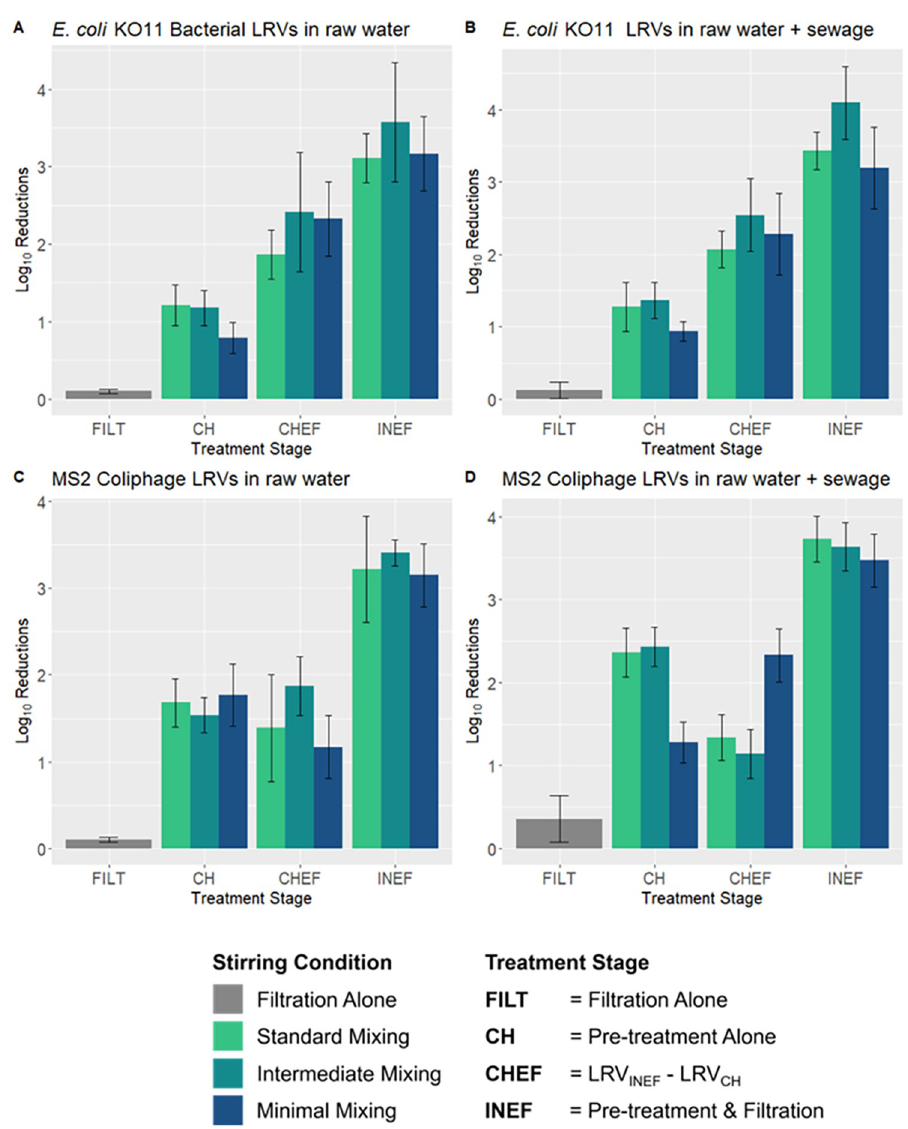
Fig 1. Mean LRVs and their 95% confidence limits (as bar whiskers) by test microbe, test water, stirring condition, and sampling point. (A) E . coli KO11 bacterial LRVs in raw water; (B) E . coli KO11 bacterial LRVs in raw water + 1% pasteurized sewage; (C) MS2 bacteriophage LRVs in raw water; (D) MS2 bacteriophage LRVs in raw water + 1% pasteurized sewage. There was no significant difference of MS2 coliphage reductions when comparing the three stir- ring conditions (Table 1). Reductions due to chitosan pre-treatment alone were, on average, 1.61 Log higher than filtration alone ( p-value < 1 . 0 × 10 −5 ) (Table 1). Reductions due to the com- 10 bined effects of chitosan pre-treatment and filtration were, on average, 3.21 Log reduction differ- 10 ences higher than filtration alone ( p-value < 0 . 00001 )(Table 1). Turbidity LRVs Average turbidity LRV differences from intermediate stirring conditions and filtration had a mean difference of 0.24 Log reductions above the combined efforts of minimal stirring 10